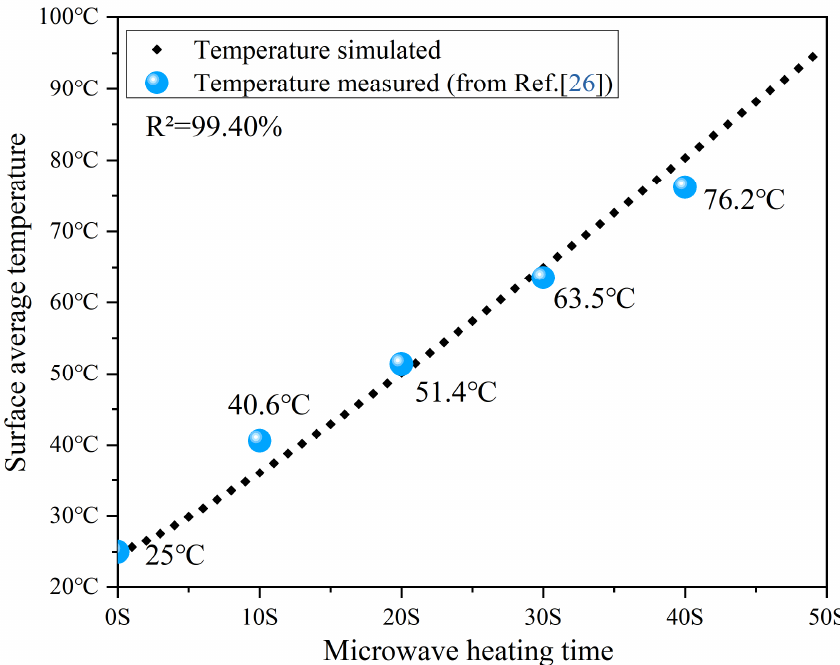
Figure 4. The surface average temperature comparison of asphalt mixtures between laboratory tests